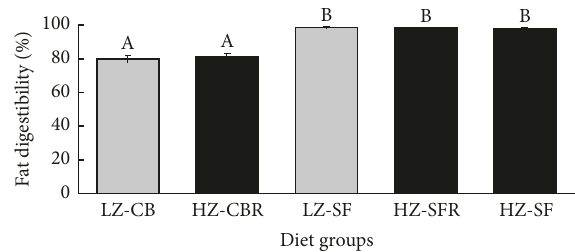
Figure 1: Fat digestibility during wk 3 and 4 of feeding male weanling rats diets containing 22% cocoa butter or safflower oil. Columns represent means ± SDs, 𝑛 = 8 . Labeled means without a commonletterdiffer, 𝑃 < 0.05